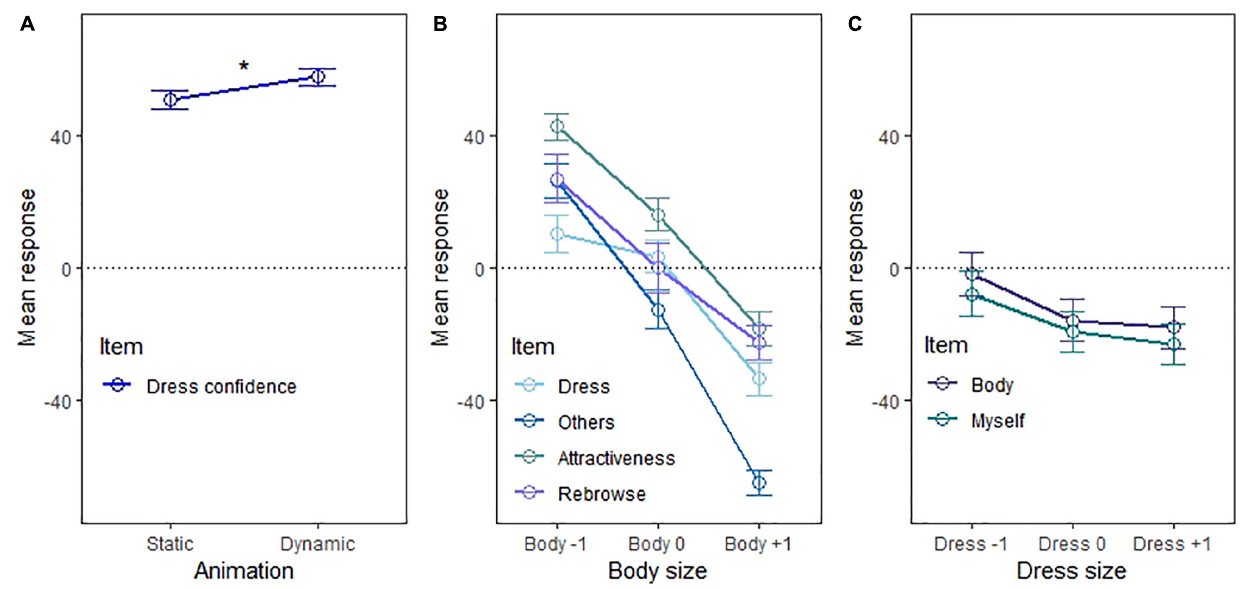
FIGURE 2 | Main effects of (A) Animation, (B) Body size, and (C) Dress size. Dress = How likely do you think it is that this dress fits you? , Dress confidence = How certain are you? , Body = I feel as if the body of the avatar is my own body , Myself = The avatar reflects how I consider myself to be , Others = I consider the avatar to reflect how I want to present myself to others , Attractiveness = How attractive do you find the woman represented by this avatar? , Rebrowse = How likely do you think it is that you would choose this avatar as your avatar for online shopping? Body/Dress –1 = One body/dress size smaller than participants’ real body/dress size, Body/Dress 0 = Participants’ real body/dress size, Body/Dress +1 = One body/dress size bigger than participants’ real body/dress size.